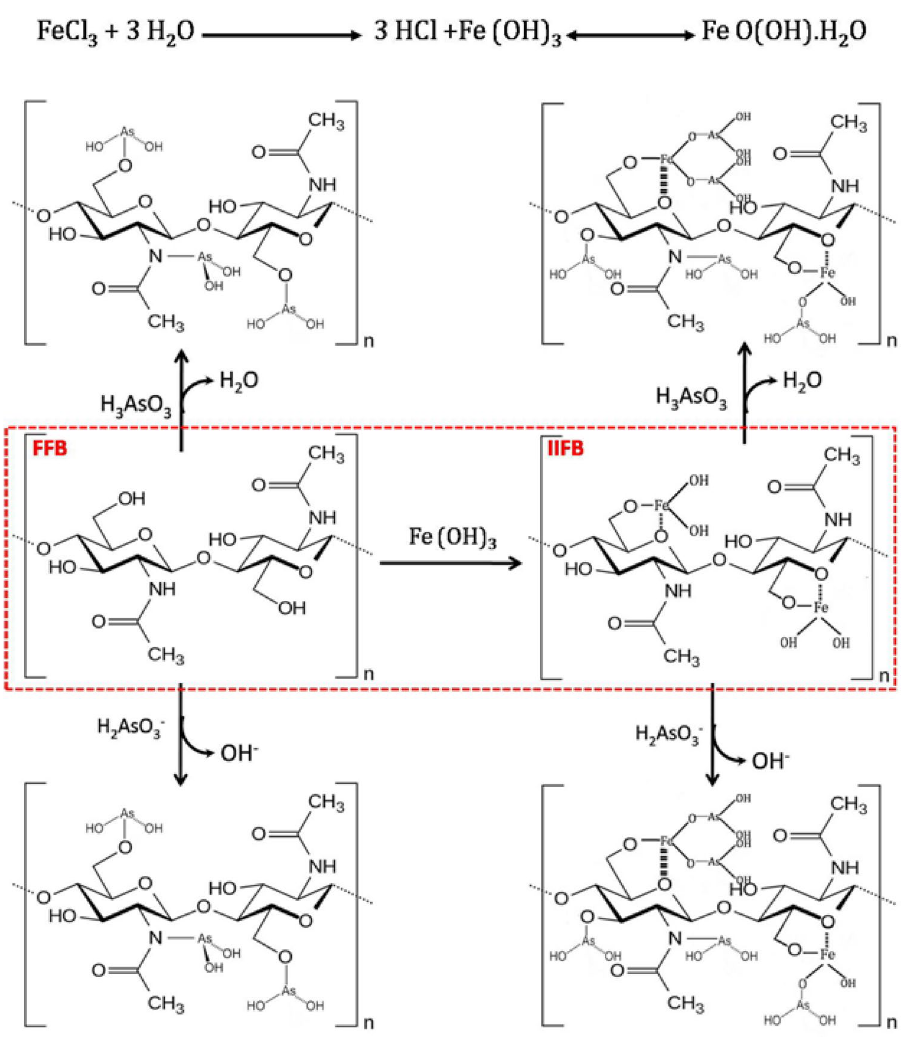
Figure 3. Proposed mechanism of As(III) biosorption over raw and iron impregnated fungal biomass (FFB and